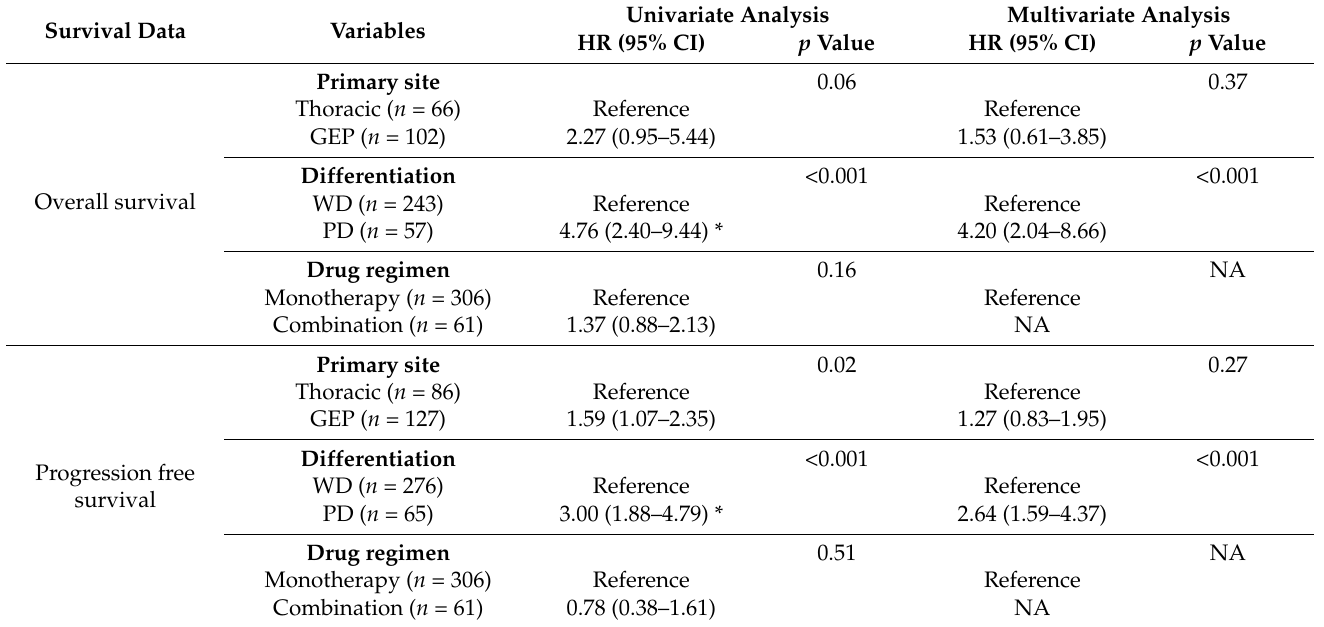
Table 3. Stratified Cox regression analysis of overall survival and progression-free survival using individual patient